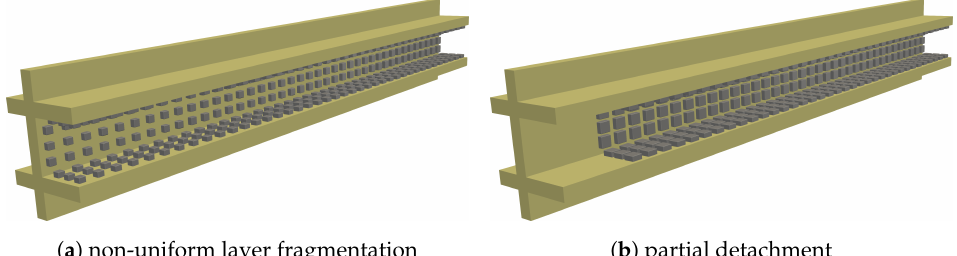
Figure 6. Channel model with modified substrate